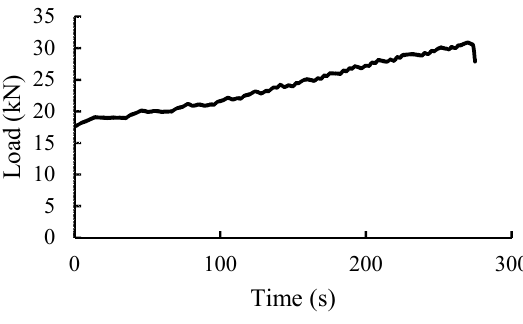
Figure 16. Vertical jack loading of Hg specimen.